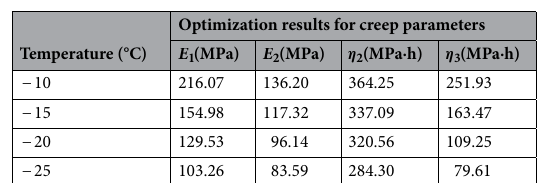
Table 3. Fuzzy random optimization of the Burgers creep damage model parameters (σ ≤ σ s ).